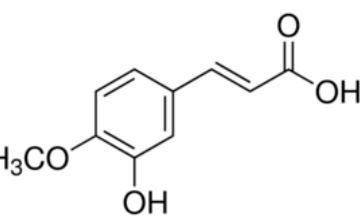
Figure 1. Chemical structure of isoferulic acid (IFA). Table 1. Biological activity of isoferulic acid.